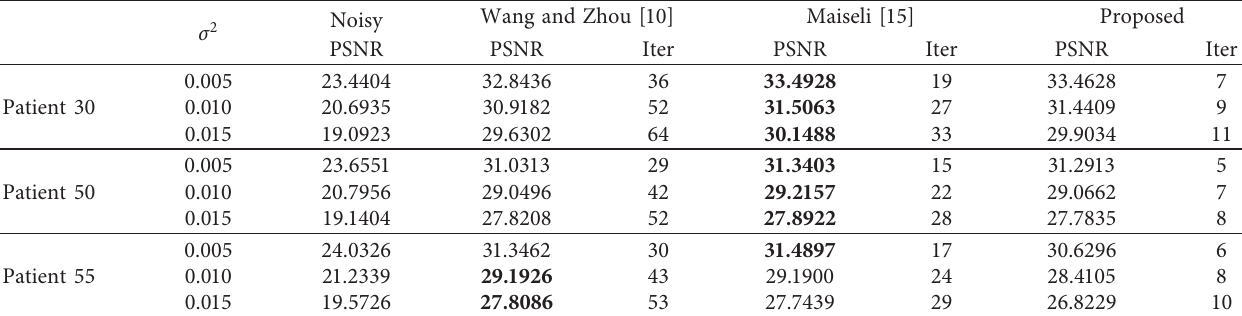
Table 1: PSNR values of the images in Figure 1 are affected by different σ 2 values of zero-mean white Gaussian noise and restored from different methods with their corresponding iteration number.